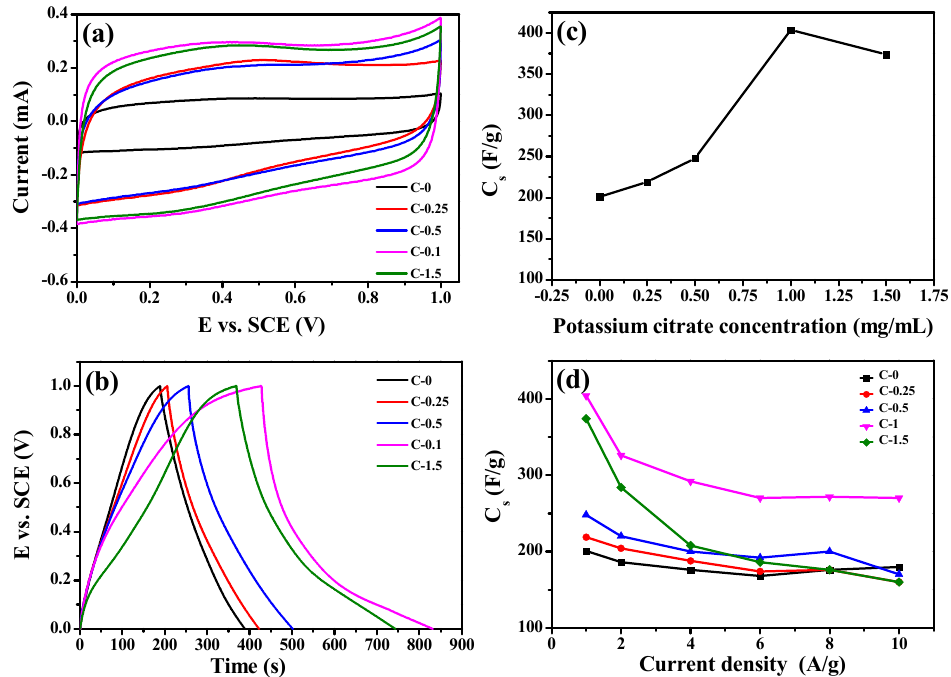
Figure 5. ( a ) The CV curves of C − 0,C − 0.25,C − 0.5,C − 1,C − 1.5 in 1 mol/L H 2 SO 4 at 500mv/s at 25 °C, ( b ) The relationship between specific capacitances and composites nanofiber prepared with different potassium citrate concentrations from 0 to 1.5mg/mL at 1.0 A/g, ( c ) Charge-Discharge curves of C − 0, C − 0.25, C − 0.5, C − 1, C − 1.5 at 1.0 A/g, ( d ) The relationship between thespecific capacitance and the current density of C − 0, C − 0.25, C − 0.5, C − 1, C − 1.5.